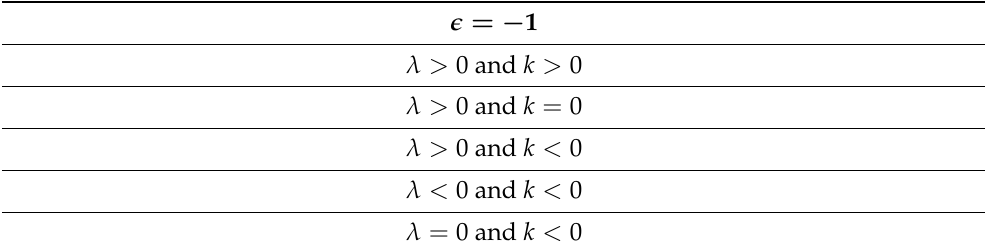
Table 4. Possible independent solutions for (cid:101) = −